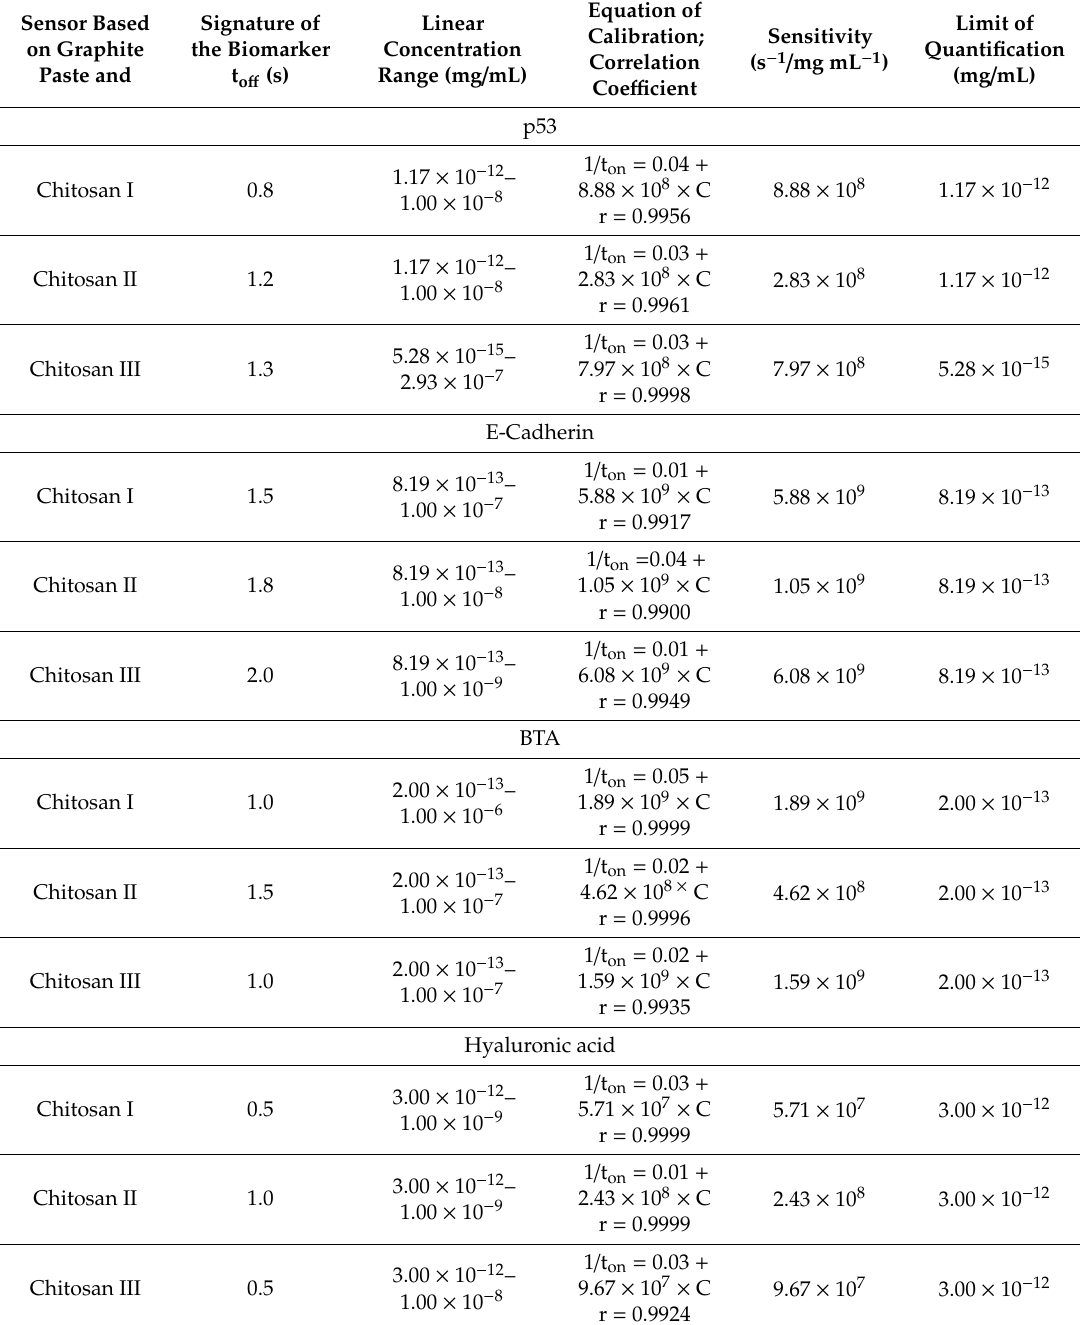
Table 1. The response characteristics of the stochastic sensors used for the assay of p53, E-cadherin, BTA, and hyaluronic